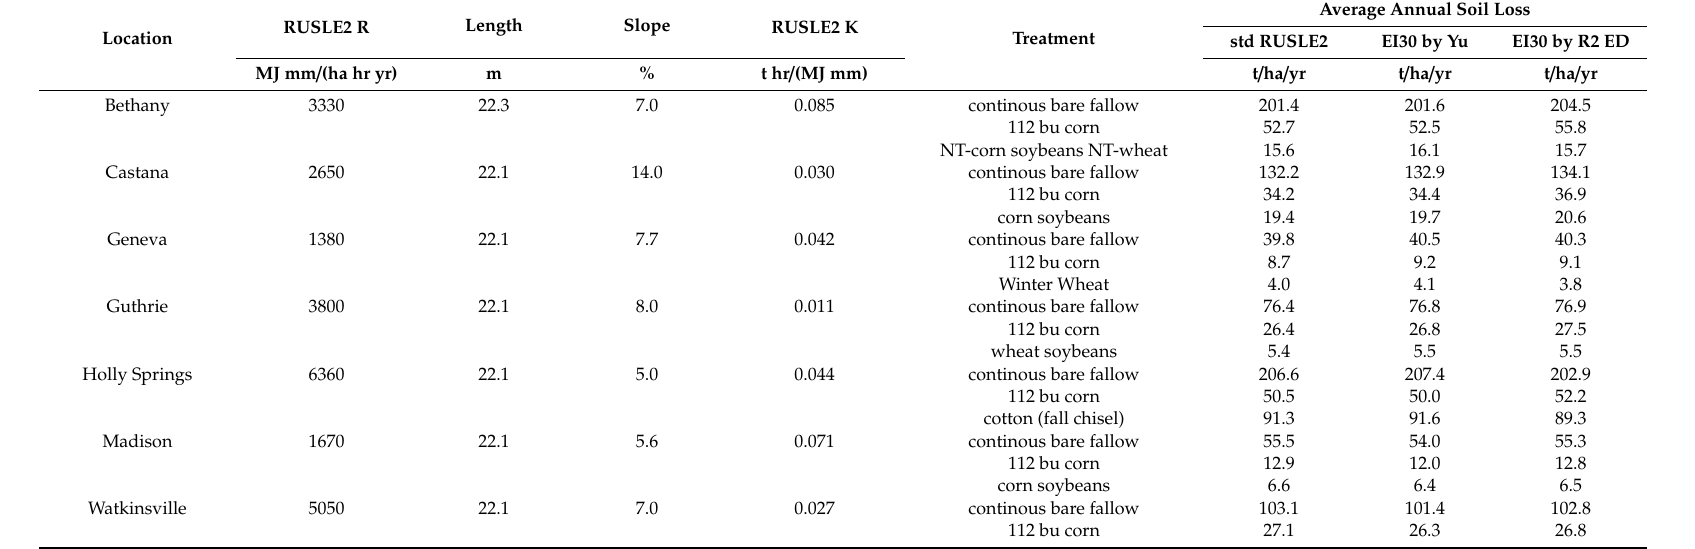
Table 3. Annual soil loss from plots predicted by RUSLE2 and by using CLIGEN for 100 years with R d values predicted by the Yu method and RUSLE2 erosivity density values (source: Kinnell and Yu (under review)